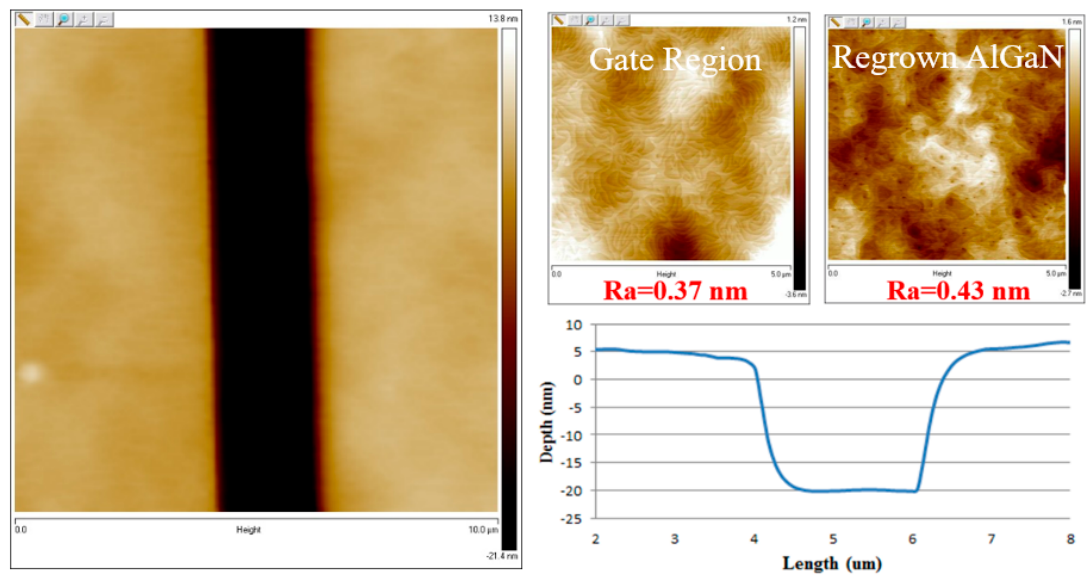
Figure 2. The AFM images gate trench profile before and after selective area ohmic regrowth.